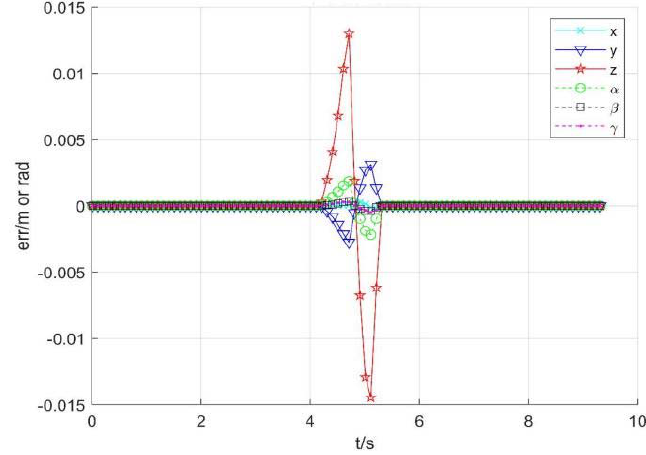
Figure 12. The tracking errors of position and orientation.